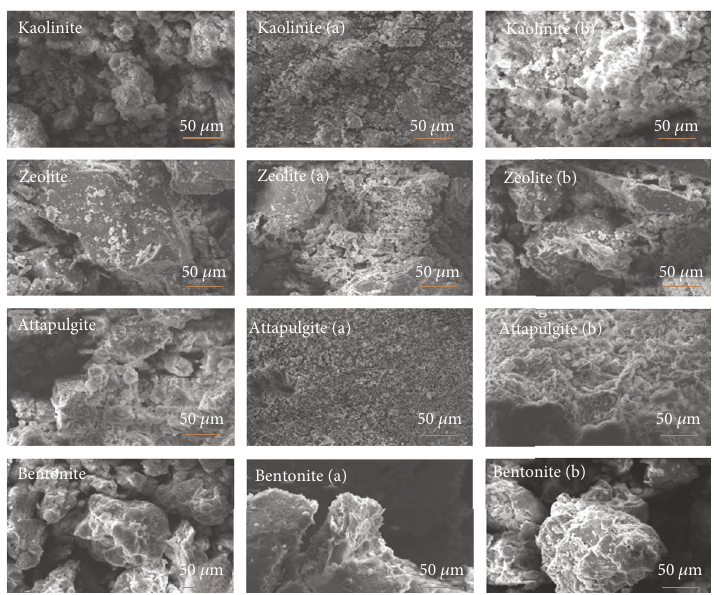
Figure 3: SEM patterns of four NCMs before and after adsorption of ammonia nitrogen (a) and phosphate (b). Table 1: The BET surface area, total pore volume, and average pore diameter of four